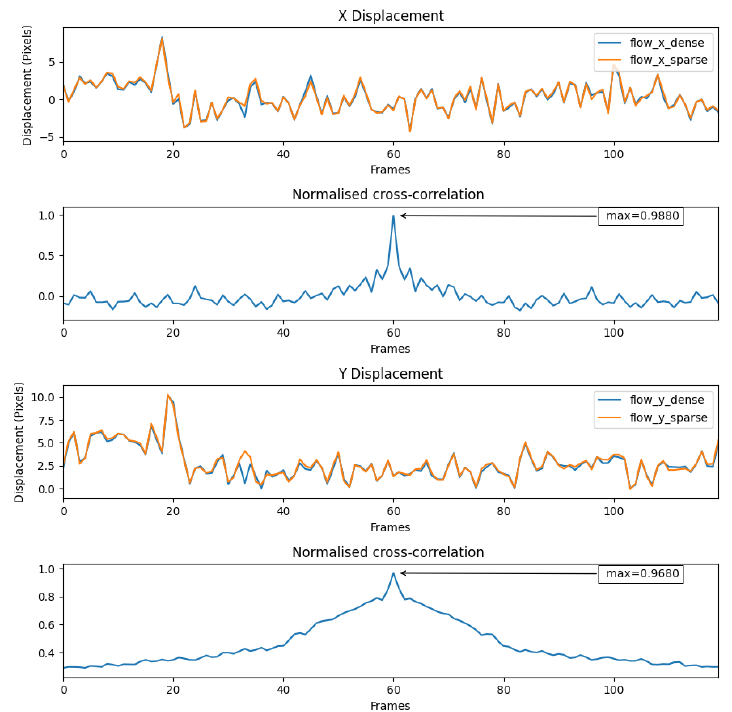
Figure 15. Dense and sparse technique signals on dataset 1.